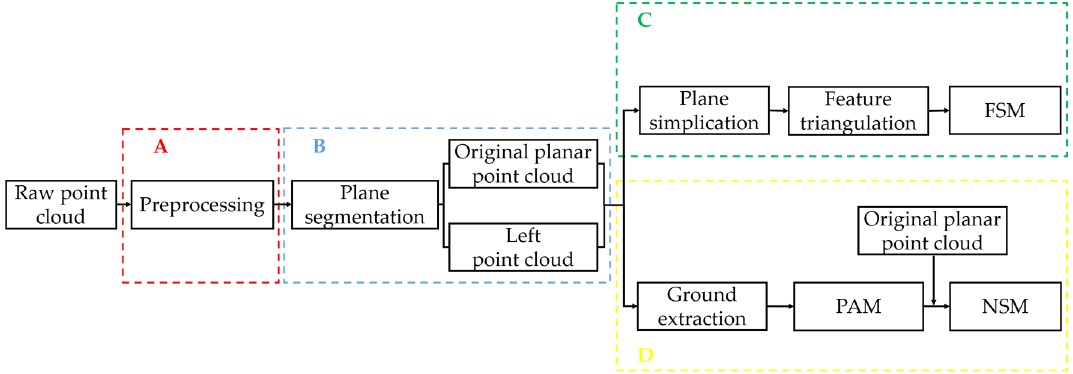
Figure 1. The overall processing pipeline of the proposed method.